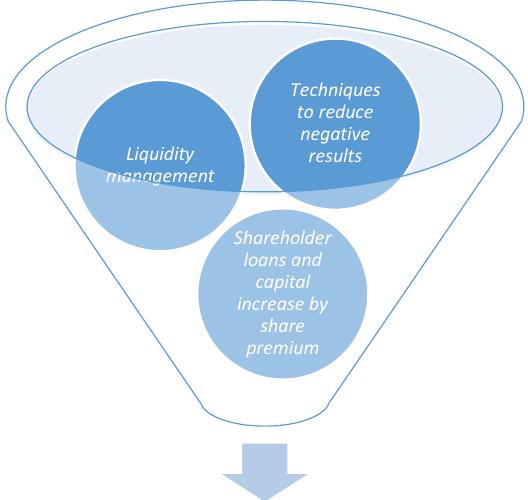
Figure 3. Capital and liquidity